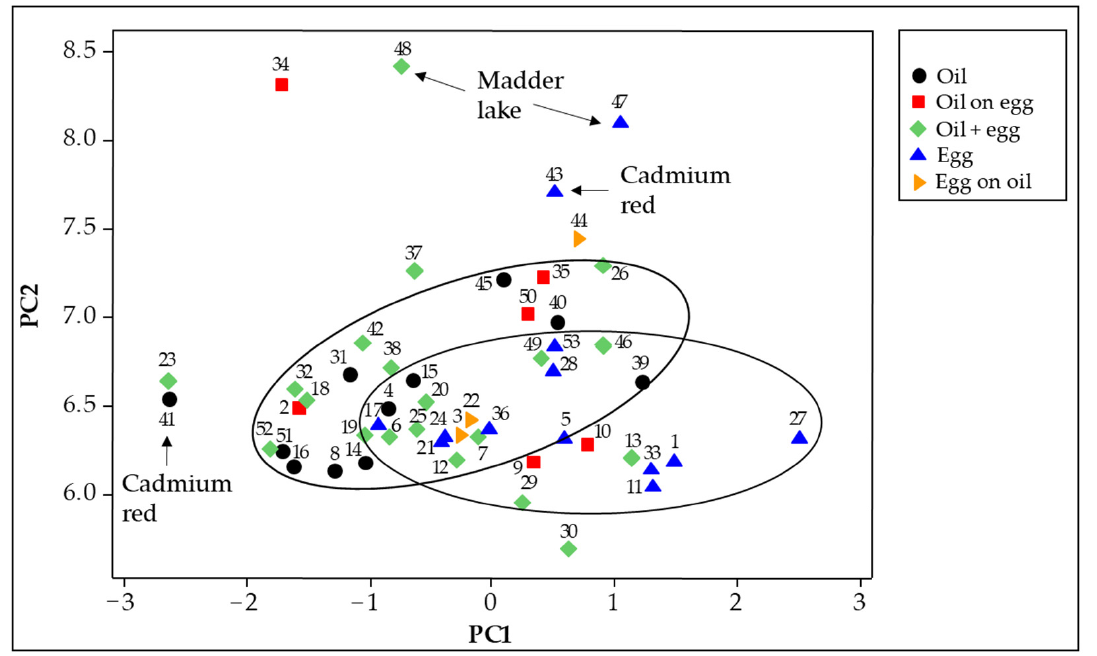
Figure 6. Score plot of the first two principal components of the emission spectra ( λ exc = 365 nm) of pictorial layers with egg tempera and oil as binders, pure or in mixture and super-imposed layers (explained variance 90.2%). The models containing just a drying oil or egg are highlighted by the two ellipses. For the numbering of the samples, see Table 1.